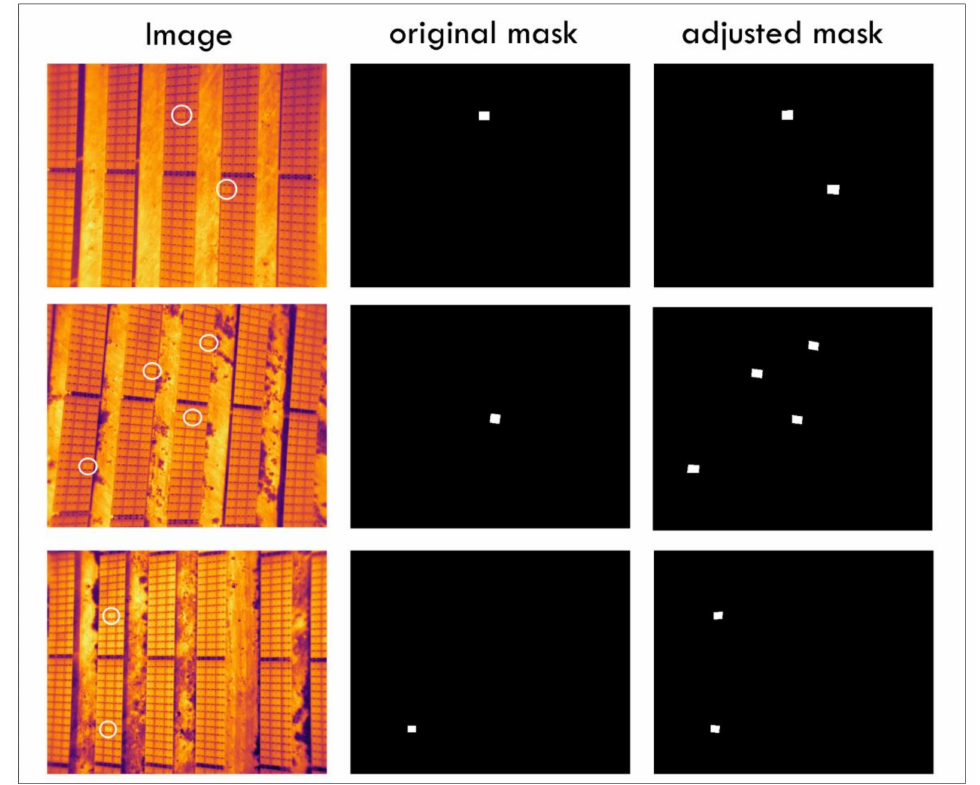
Figure 2. Example mask images of incorrect annotation, the white circles and squares show the defective cells on the image. About 10% of the dataset has incorrectly annotated image